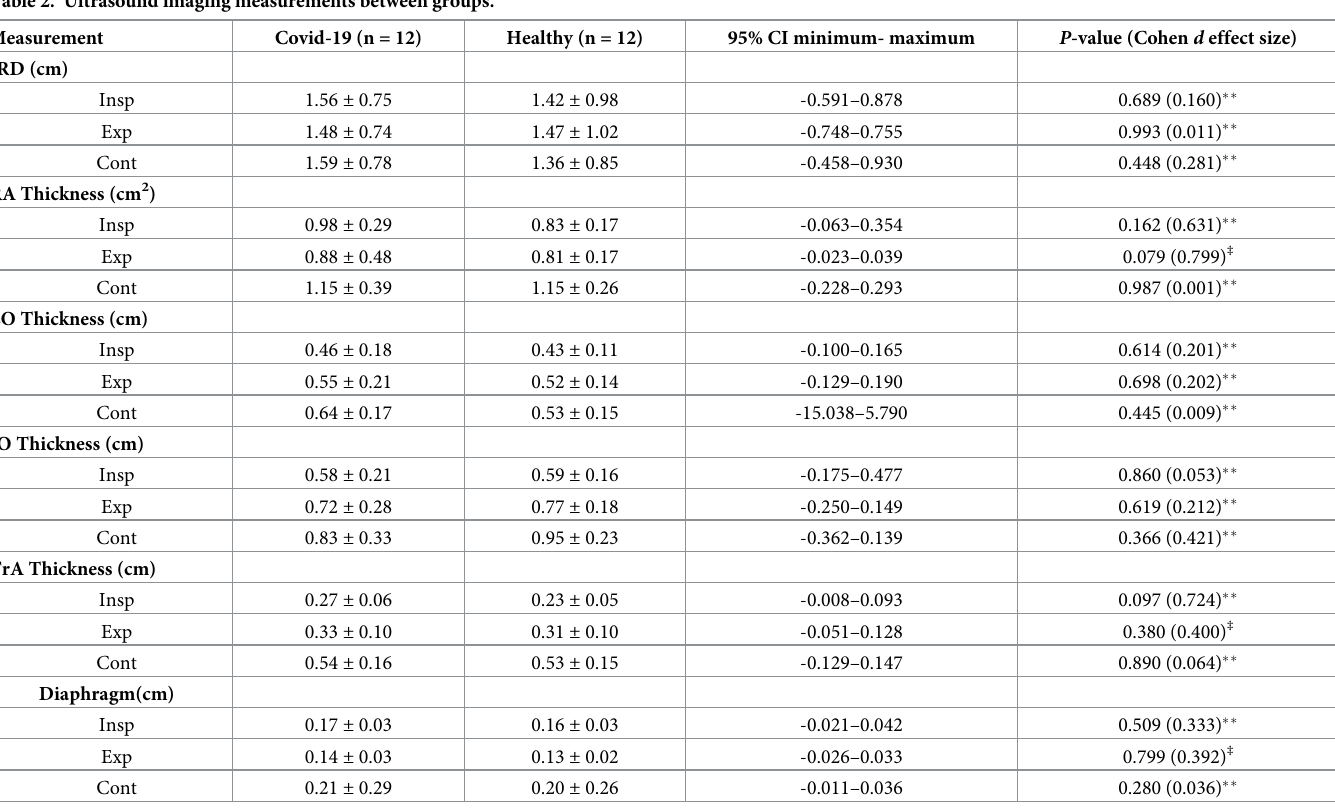
Abbreviations: Cont, contraction; Exp, expiration; Insp, inspiration �� Student´s t -test for independent samples was performed.